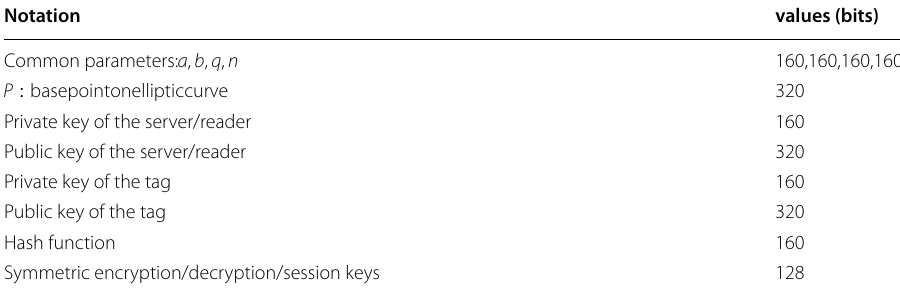
Table 10 List of variables and their values